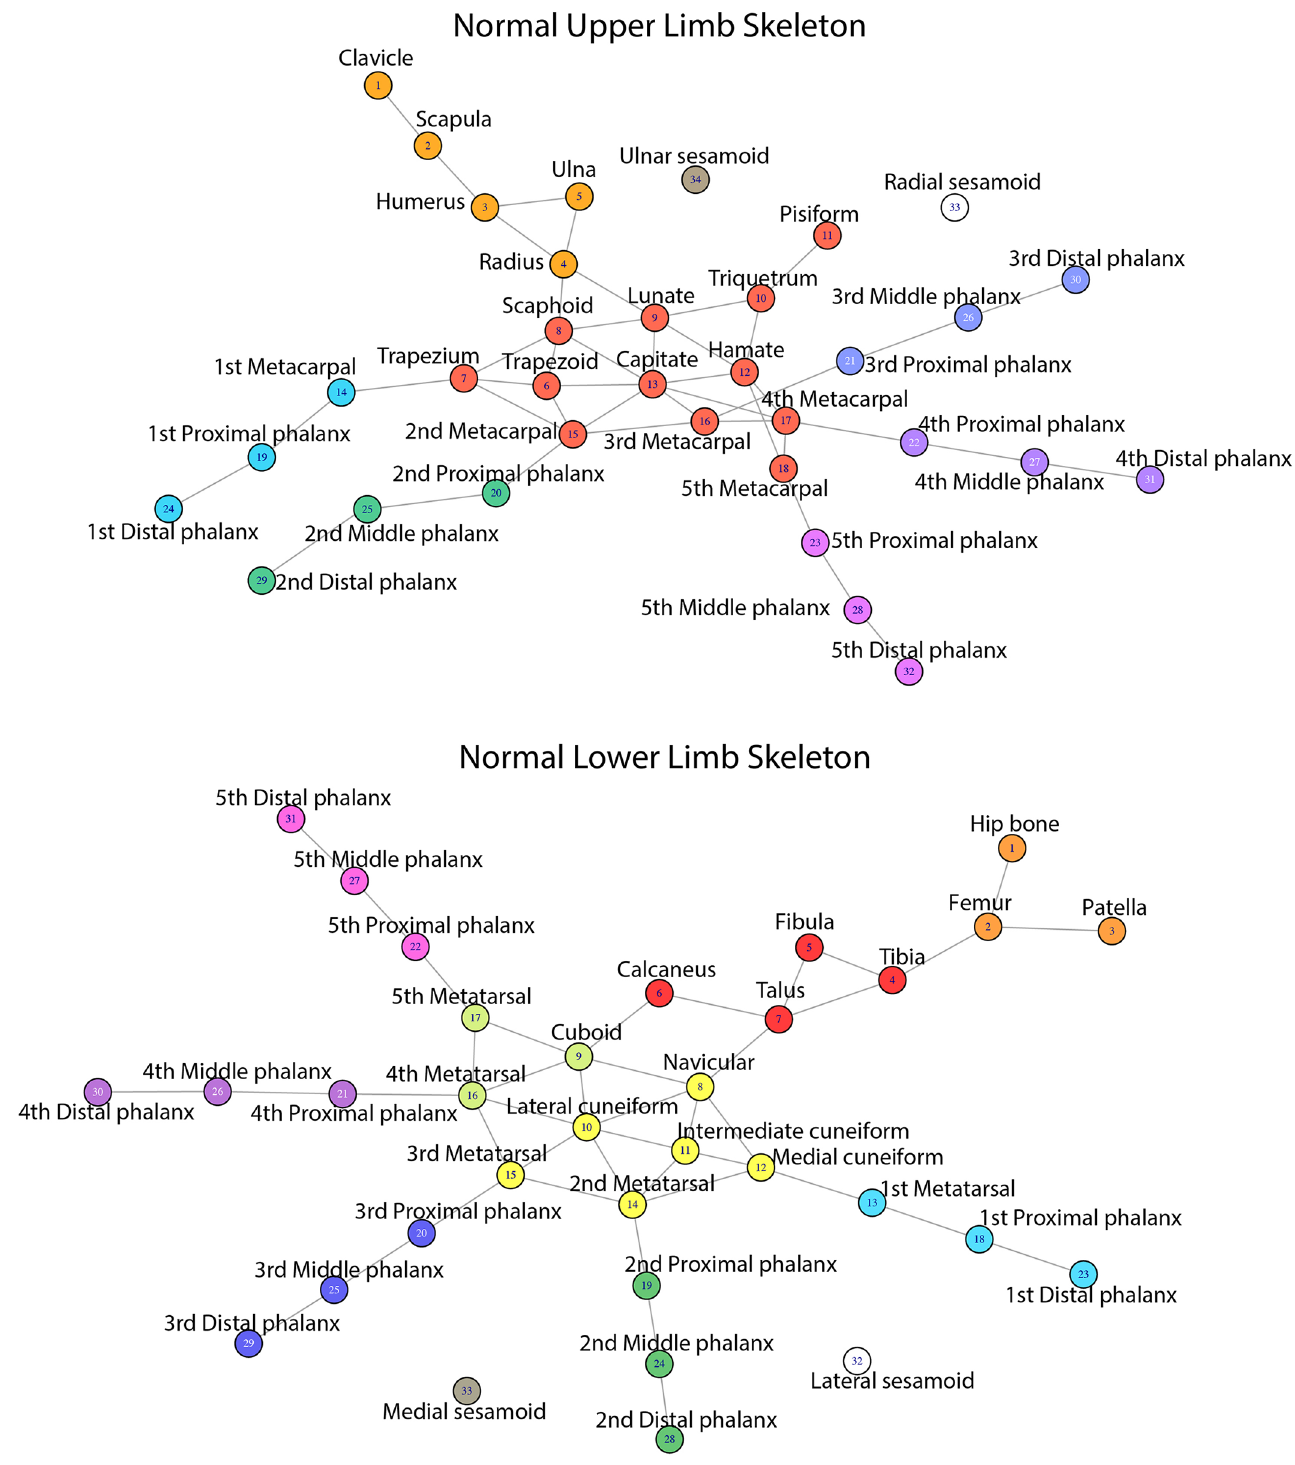
Fig 1. Network plots of normal adult left UL and left LL identified using AnNA. To see similar network plots for all the other skeletal, as well all the muscular and musculoskeletal, systems of all limbs, see S1 – S24 Figs (see S1 Methods for labels).